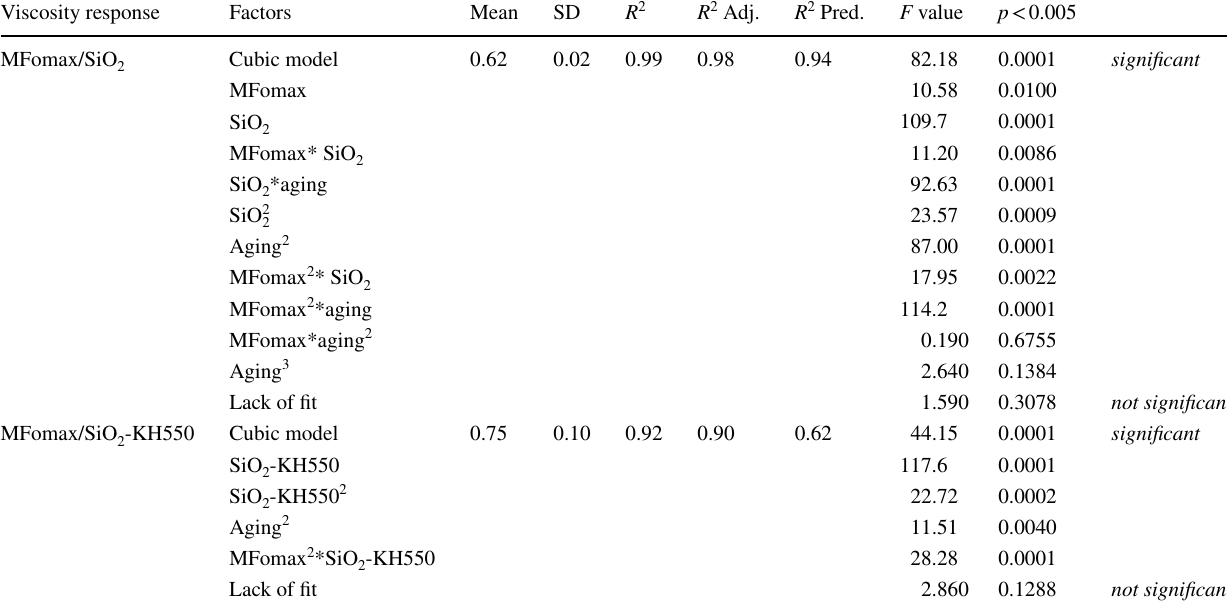
Table 4 Statistical data and analysis of variance (ANOVA) for viscosity of the NF Viscosity response Factors